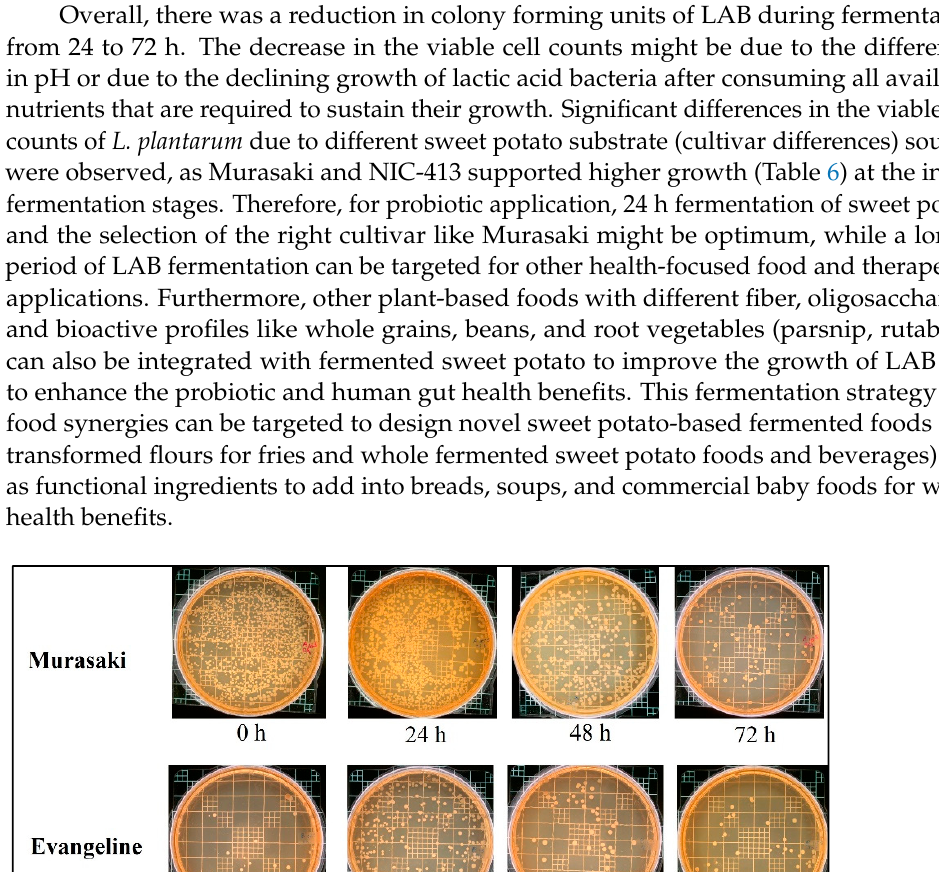
Table 6. Viable cell count (Log CFU/mL) of Lactiplantibacillus plantarum with three different dilutions ( 10 − 3 , 10 − 4 , 10 − 5 ). in fermented sweet potato samples at 0, 24, 48, and 72 h fermentation time points. Sweet Po-